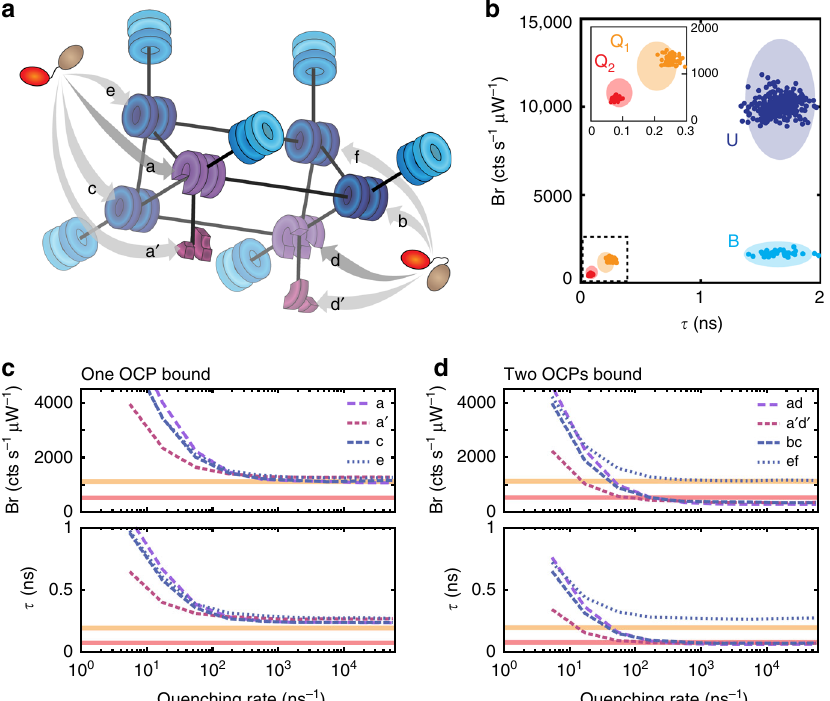
Fig. 5 Compartmental model of OCP-quenched CB-PB phycobilisome for one and two quenchers. a Schematic structure and connectivity of compartmental CB-PB model, after van Stokkum et al. 61 . All components are colored and positioned according to the structure shown in Fig. 1. Eight possible quenching sites for OCP are labeled ( a – f , plus a ′ and d ′ ). b Scatter plot of brightness vs. fl uorescence lifetime simulation results for four model conditions: unquenched (U), C-PC hexamer only (B), one OCP bound at site a , a ′ , or c (Q 1 ), or two OCPs bound at site combinations ad , a ’ d ’ , or bc (Q 2 ), with an assumed quenching rate of 540 ns − 1 for each OCP compartment. Ellipses show the locations of the 95% con fi dence intervals for the four experimentally measured states U, B, Q 1 , and Q 2 , as originally depicted in Fig. 3c. c Brightness and fl uorescence lifetime of the CB-PB phycobilisome for the case of one bound quencher located at each of the four rotationally unique sites a , a ′ , c , and e , plotted for increasing quencher strength. d Brightness and fl uorescence lifetime of the CB-PB phycobilisome for two bound quenchers at each of the four unique pairs of C 2 -symmetric sites ad , a ′ d ′ , bc , and ef , plotted for increasing quencher strength. Horizontal lines in c and d show the experimentally measured parameters for Q 1 (orange) and Q 2